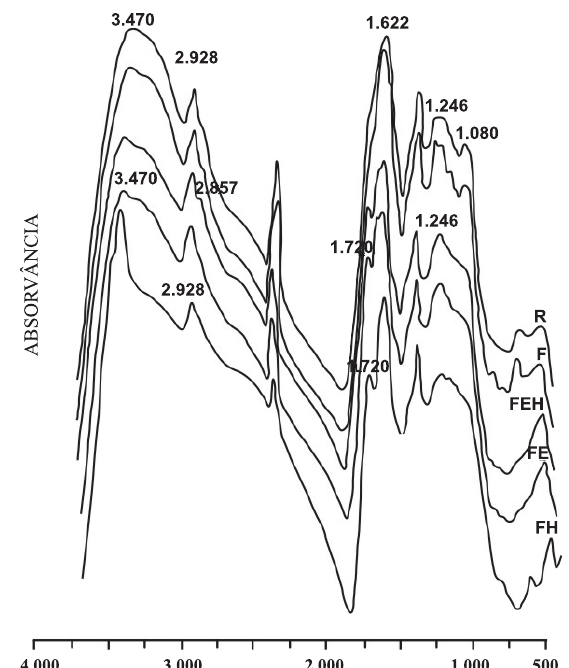
Figura 1. Espectros de infravermelho dos ácidos húmicos. F- fertirrigação com fertilizantes minerais (ureia, fosfato monoamônio, cloreto de potássio); FE- F + aplicação de 20 dm 3 / planta de esterco antes do plantio e antes da primeira poda de frutificação; FH- F + fertirrigação com 30 dm 3 ha -1 de Codahumus 20 ® ; FEH- FH + aplicação de 20 dm 3 / planta de esterco antes do plantio; R: testemunha sem